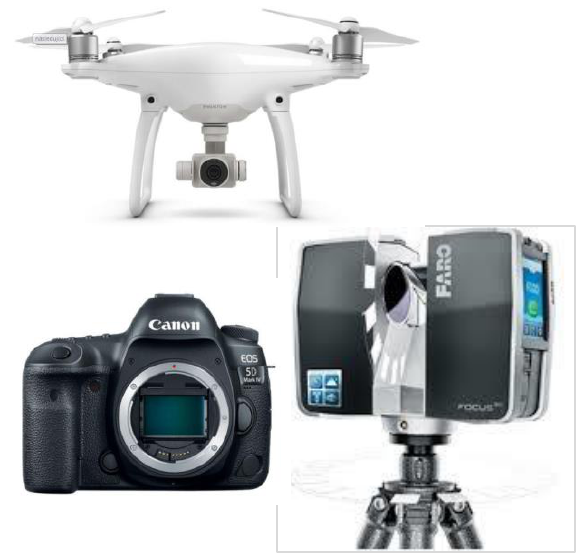
Figure 1. Instruments used: Canon D45 Mark II calibrated camera, DJI Phantom 4 drone and a Faro laser scanner